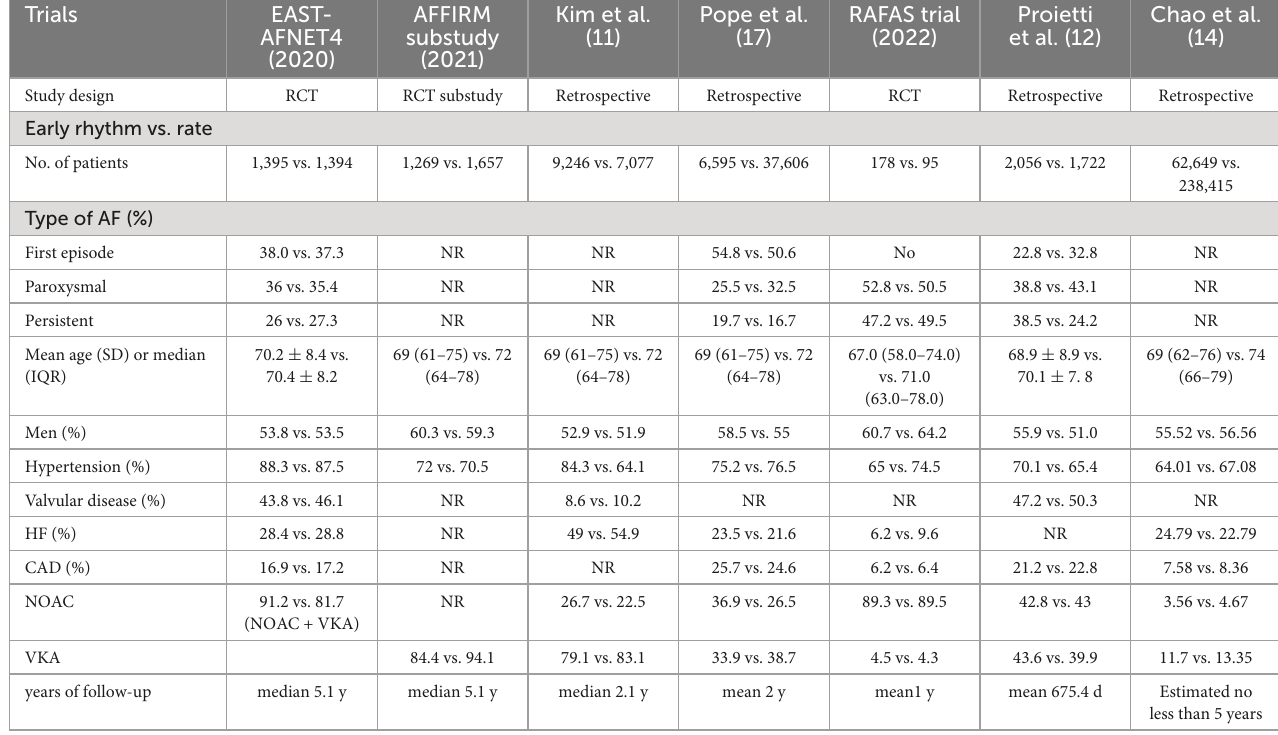
TABLE 1 Main study characteristics.